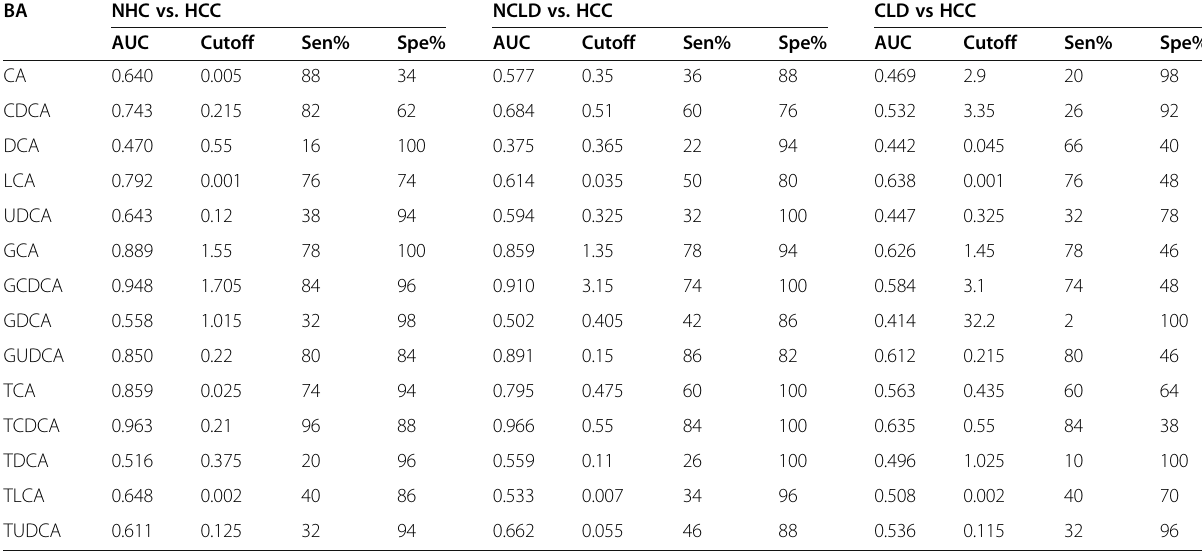
Table 3 Analytical data obtained from ROC curve analysis of 14 Bile acid. The AUC, the cutoff point at the Youden ’ s index, the sensitivity, and the specificity of each bile acid BA NHC vs. HCC NCLD vs. HCC